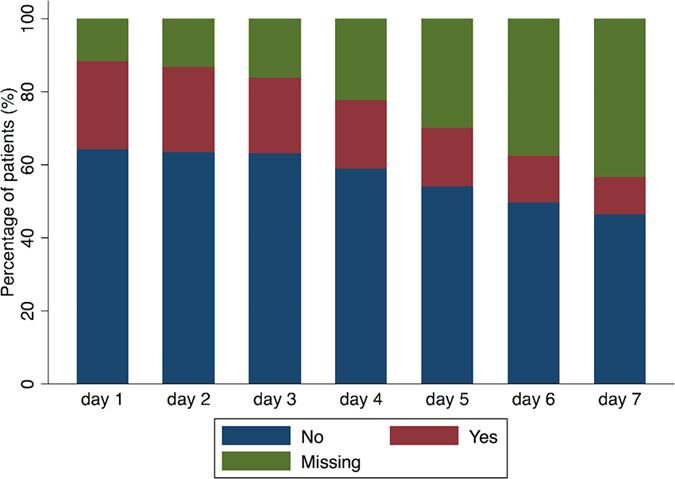
Graphical presentation of patients receiving corticosteroids, those without receiving corticosteroids and those with missing data.The proportion of patients with missing data increased from day 1 to day 7, which was attributable to ICU discharge or death (the end of follow up).